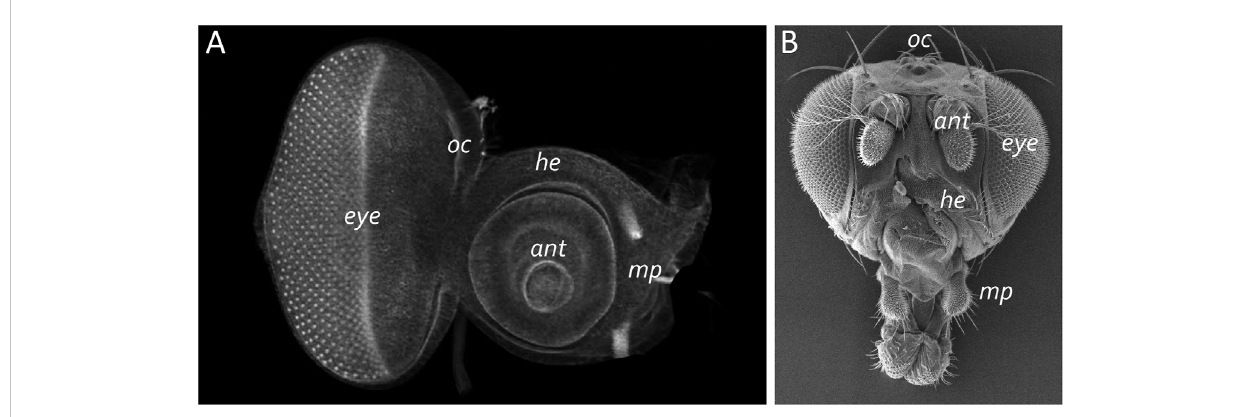
FIGURE 7 The eye-antennal disc gives rise to the adult head. (A) A light microscope image of a third larval instar eye-antennal disc. The disc is divided into several different neighborhoods that each give rise to a unique structure on the adult head. Each larva has two eye-antennal discs that are stitched togetherduringpupaldevelopment. (B) Ascanningelectronmicrographofthatadulthead.Theadultstructuresthatarederivedfromthediscarelabeled. oc, ocelli; ant, antenna; eye, compound eye; he, head epidermis; mp, maxillary palp.